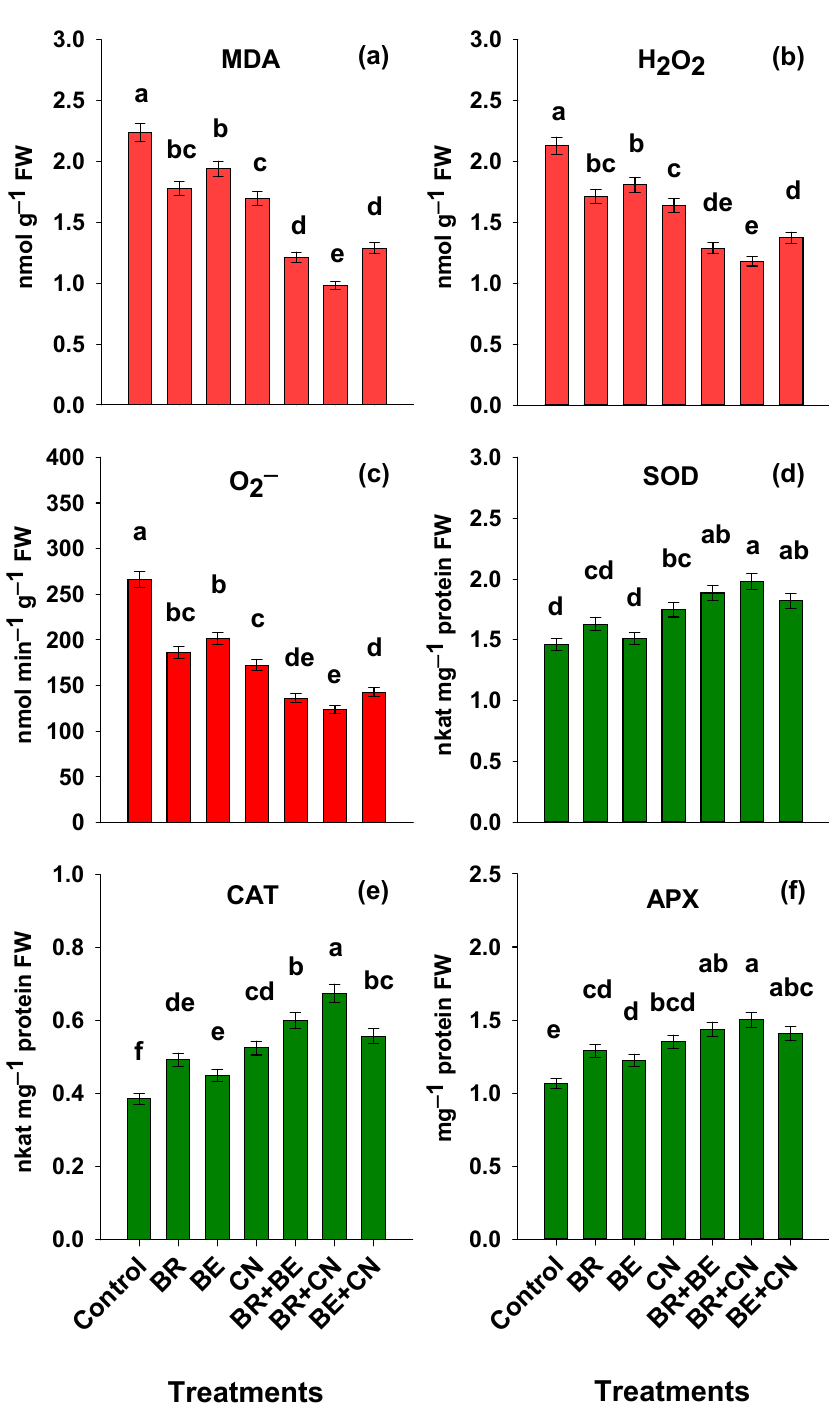
Figure 2. Leaf MDA ( a ), H 2 O 2 ( b ), O 2 − ( c ), SOD ( d ), CAT ( e ), and APX ( f ) as influenced by adding BR, BE, and CN in a Ni-affected soil. Values characterized by the same letter are not significantly different at the α = 0.05 level. These values are the mean of three replicates ± SE. Application of BR, CN, and BE in the soil affected by Ni significantly controlled the generation of O 2 − , and the contents of H 2 O 2 and MDA, whereas, upgraded APX, CAT, and SOD (except BE treatment) activities in leaves over control. However, non-significantly the highest decline of H 2 O 2 and O 2 − in leaves of lentil grown in BR+CN and BR+BE treatments was seen. These BR+CN treatment reflected maximal curtailment in H 2 O 2 and O 2 − by 45% and 40%, respectively with respect to control. In the instance of MDA, the